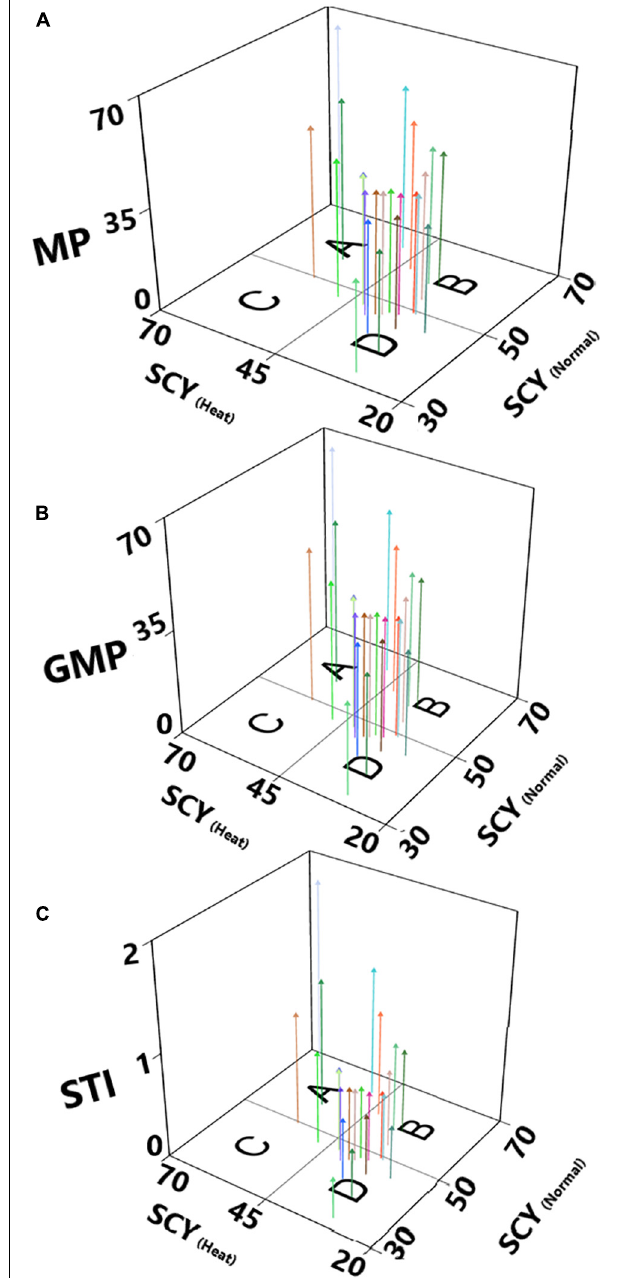
FIGURE 6 | Three-dimensional scatterplots based on seed cotton yield across normal (SCY-Normal) and heat stress (SCY-Heat) conditions, and stress tolerance indices: (A) mean performance (MP), (B) Geometric mean performance (GMP) and (C) Stress Tolerance